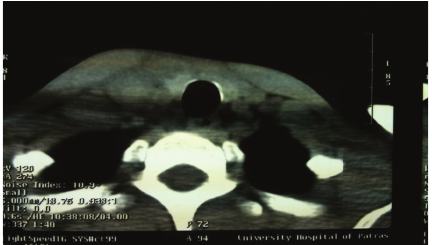
Figure 2: CT showing thrombosis in the right internal jugular vein and soft